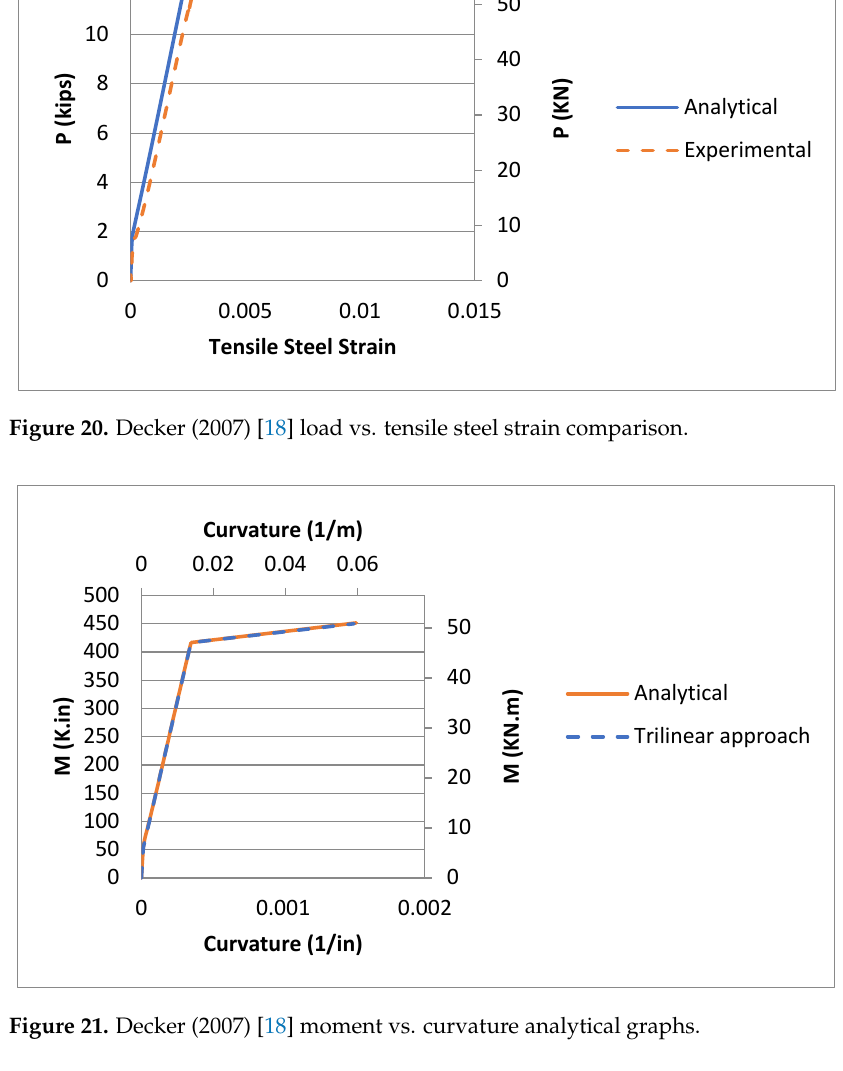
Figure 21. Decker (2007) [18] moment vs. curvature analytical graphs.